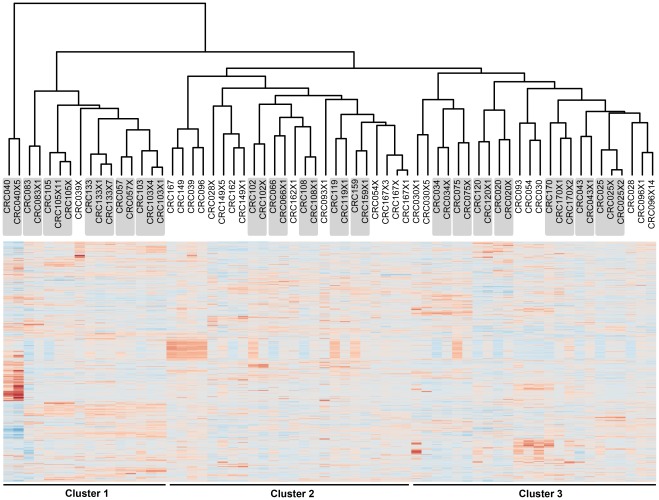
Patient tumor tissues and matched PDCCEs exhibit similar gene expression patterns.Unsupervised cluster analysis of 27 patient tumor-PDCCE matched pairs show that 22 pairs (81%) fell within the same cluster and 18 matched PDCCE (66%) clustered directly in pairs with the original patient tumor (gray boxes). Sample names containing an X denote PDCCE (xenograft) samples. The number immediately following the X indicates the generation/passage number of that particular sample.